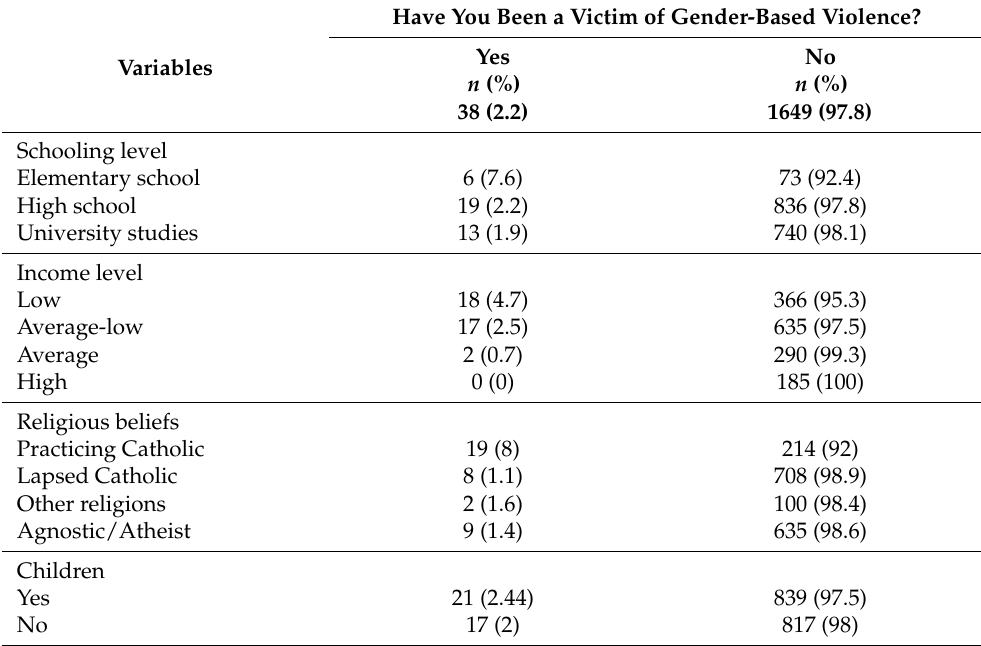
Table 4. Factors associated with having being victims of gender-based violence during confinement.